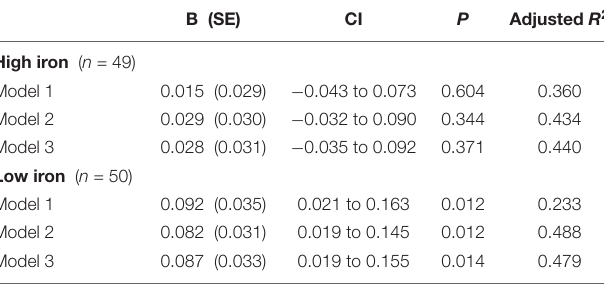
TABLE 9 | The results of multiple linear regression analyses assessing the associations between the serum copper level and MMSE by iron